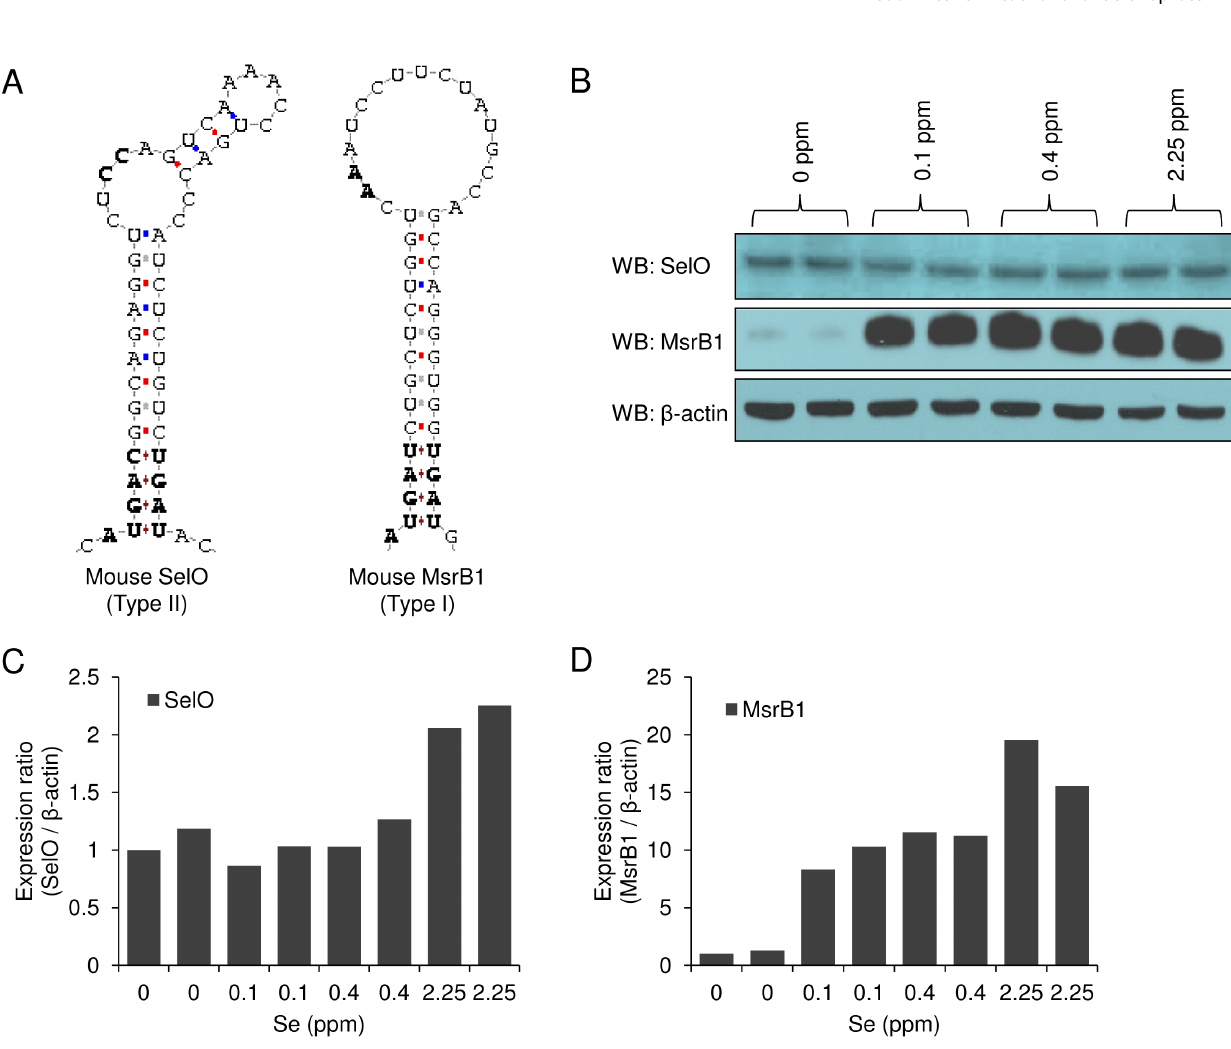
Table S1 PCR primers used in cloning and preparation of chimeric gene expression constructs.